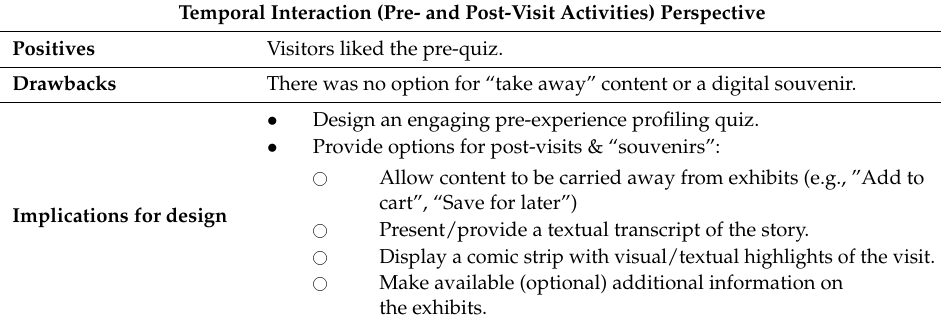
Table 7. Insights from findings on the temporal experience perspective, and implications for